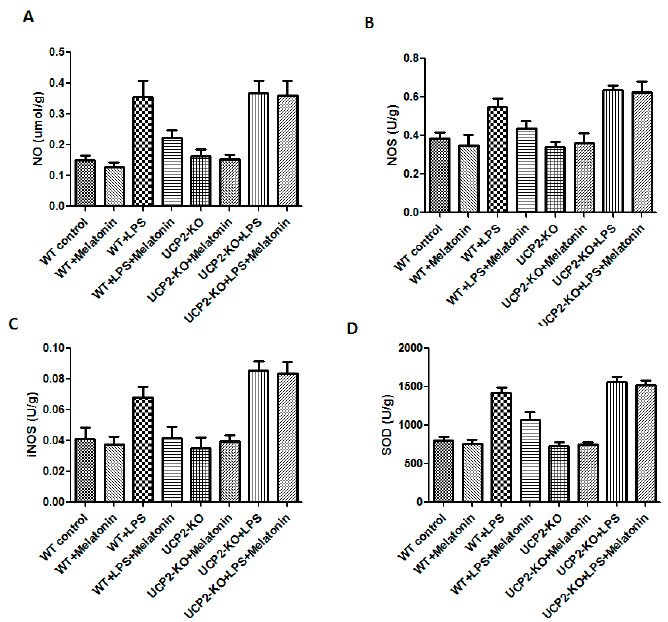
Figure 5. Effect on nitric oxide (NO), nitric oxide synthase (NOS), inducible nitric oxide synthase (iNOS), and superoxide dismutase (SOD) production in the heart tissues. Panel ( A ): NO. Panel ( B ): NOS. Panel ( C ): iNOS. Panel ( D ): SOD.